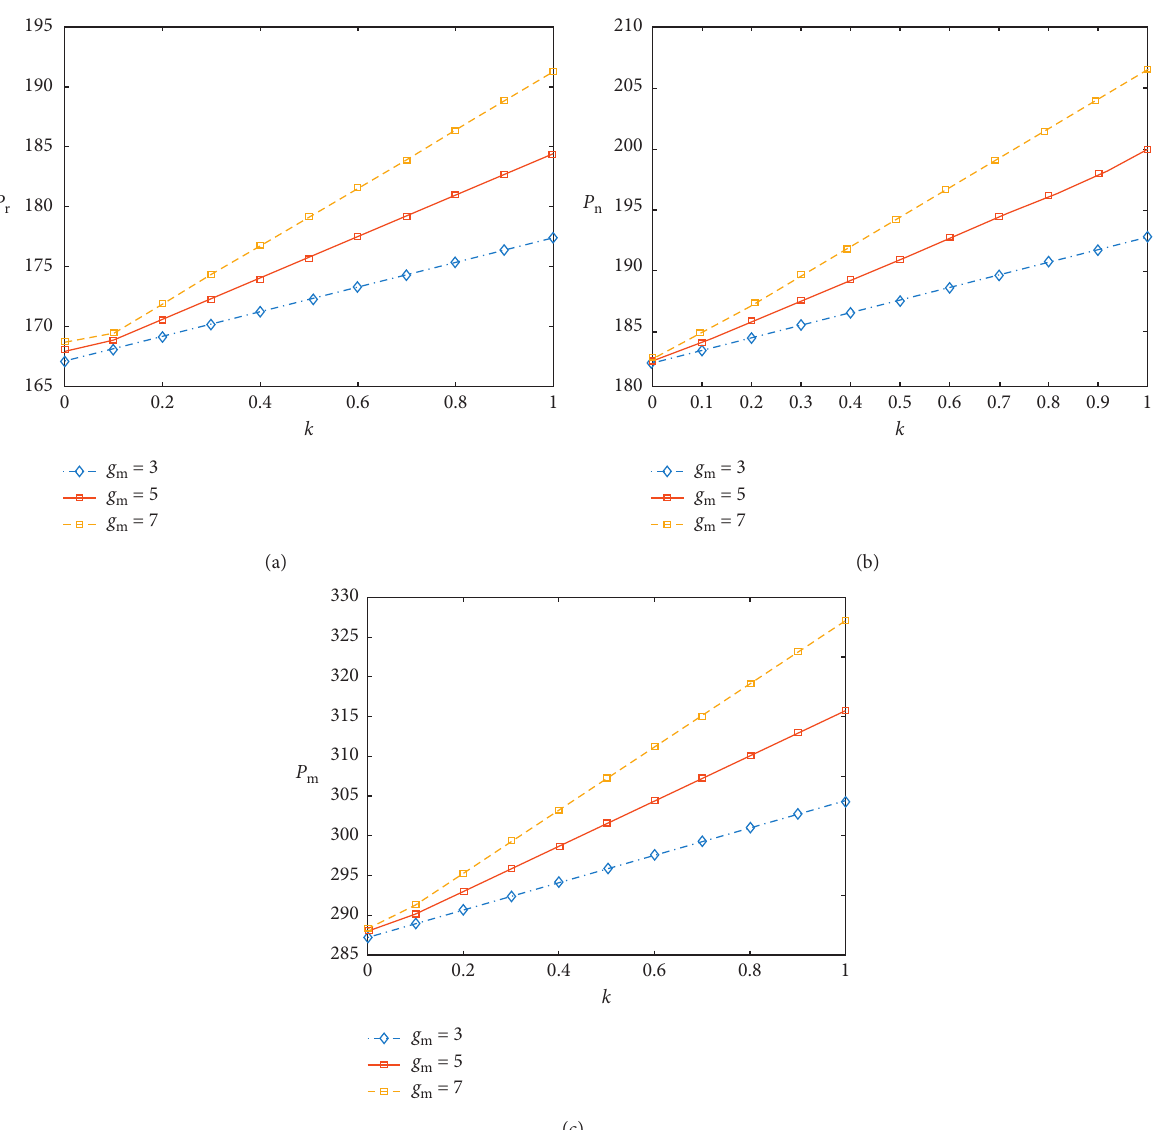
, p , and p on recycling prices p : (a) the m r n m ; (b) the influence of consumers’ green recycling consciousness r m